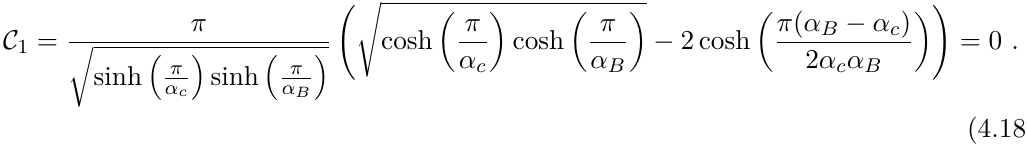
Figure 1 . In (1+1) dimensions the quantity ∆ E 2 accelerating detectors with respect to the inverse temperature σ = β ∆ E for different fixed α a A / ∆ E . The other parameter is fixed at α B = a B / ∆ E = 1